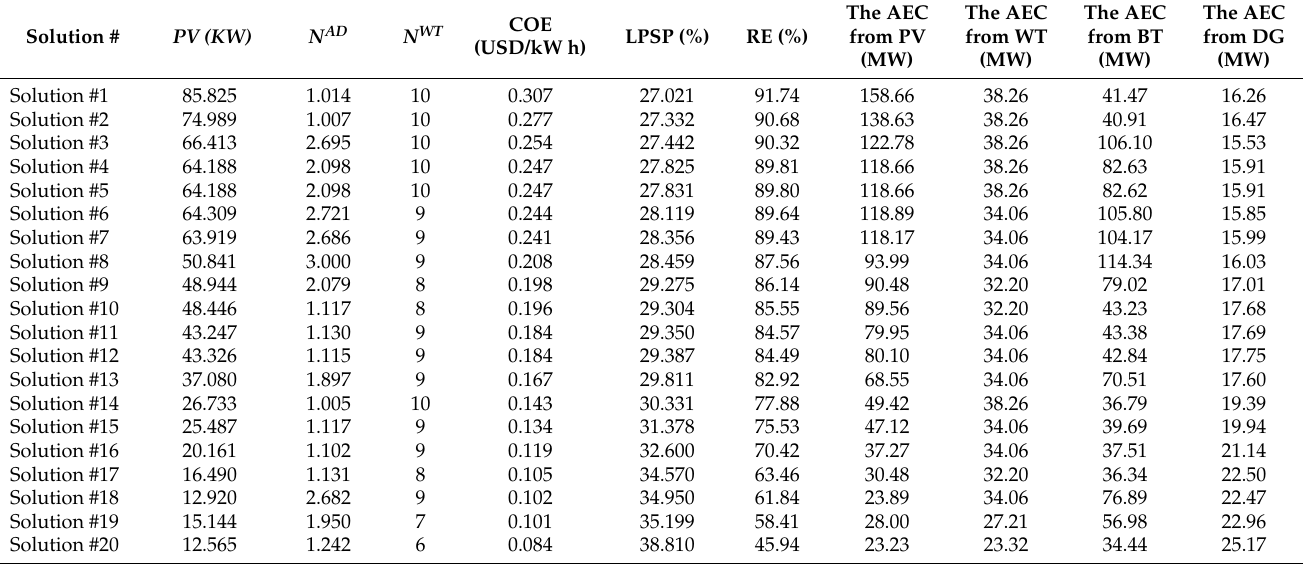
Table 8. Selected solutions from the Pareto front of